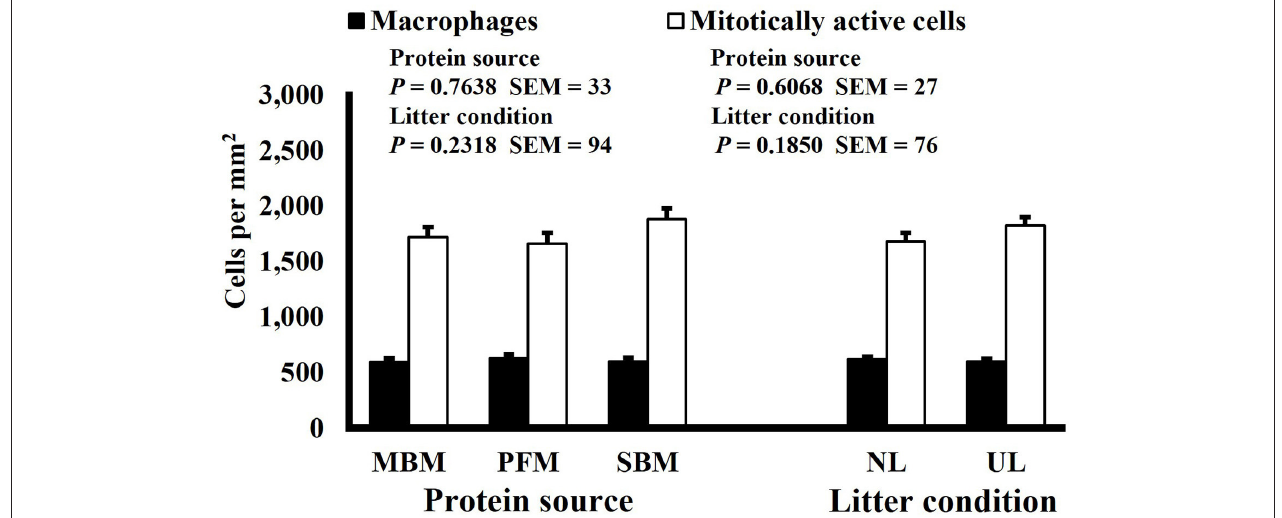
FIGURE 10 | Effect of dietary protein source and litter condition on macrophage (KUL01 + ) and mitotically active (BrdU + ) cell densities (cells per mm 2 ) in the duodenum of 8-d-old broilers ( n = 36 per sampling d, 6 birds per treatment). MBM, meat and bone meal; PFM, 50% poultry by-product and 50% feather meal blend; SBM, soybean meal; NL, new litter; UL, used litter. a,b Bars of the same color representing means from either dietary protein source or litter condition with different superscripts differ at P ≤ 0.05.